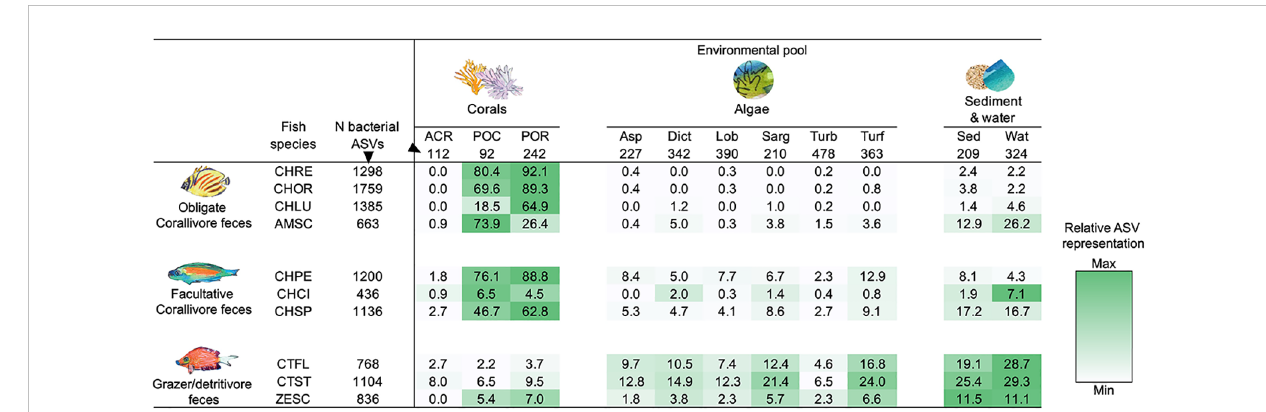
Table S5). By comparison, grazer/detritivore feces contained only up to 9.5% of distinct ASVs associated with Porites lobata species complex ( C. striatus ; 23 of 242) and up to 6.5% of the ASVs identi fi ed in Pocillopora species complex ( C. striatus ; 6 of 92). ASVs associated with A. hyacinthus were much less frequently identi fi ed in corallivore feces (up to 2.7%; C. spilurus ), but these corals were relatively uncommon at our study site during the sampling period and were not frequently consumed by corallivores (Grupstra et al., 2021). Grazer/detritivore feces contained high representation of ASVs that were associated with different types of algae (Figure 3; Table S5). For example, 24.0% of turf algae ASVs were identi fi ed in feces of C. striatus (87 of 363 ASVs), whereas only up to 3.6% of turf algae ASVs were found in obligate corallivore feces ( A. scopas ; 13 of 363 ASVs). In addition, feces of the grazer/detritivores C. fl avicauda and C. striatus contained higher numbers of the ASVs associated with all other categories of algae (up to 21.4%) than did feces of obligate (up to 5.0%) or facultative corallivores (up to 12.9%; Figure 3; Table S5). Feces of these species also contained more of the ASVs found in sediment and water samples ( C. striatus ; 25.4%, 53 of 209 ASVs and 29.3%, 95 of 324 ASVs), than did other trophic guilds (but note that the obligate corallivore A. scopas and the facultative corallivore C. spilurus also had high representation of ASVs found in sediment and water). Interestingly, while feces from the grazer/detritivore Z. scopas also contained more ASVs associated with algae (1.8-6.6%) than feces of the obligate corallivores (0.0-3.8%), the representation of algal ASVs in Z. scopas feces was noticeably lower than in feces of the other grazer/detritivores (4.6-16.8% for C. fl avicauda ; 6.5-24.0% for C. striatus ). In fact, Z. scopas appeared more similar to two of the sampled facultative corallivores ( C. pelewensis : 2.3-12.9% and C. spilurus : 2.7-9.1%; see Figure 3; Table S5) than to grazer/ detritivores in terms of the ASVs it shared with algae. Facultative corallivore feces contained a mix of ASVs associated with corals and algae. For example, C. pelewensis contained 88.8% of the ASVs found in Porites lobata species complex (215 of 242 ASVs;